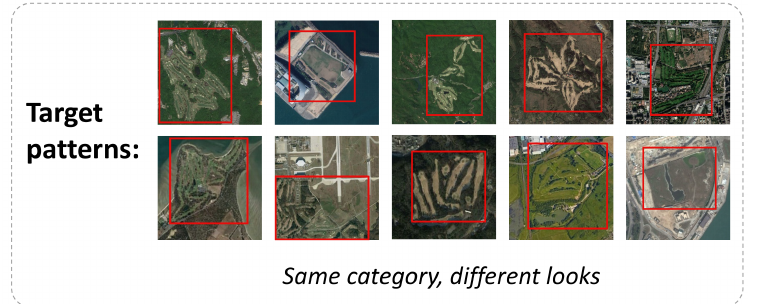
Figure 17. The illustration of target patterns of golf track